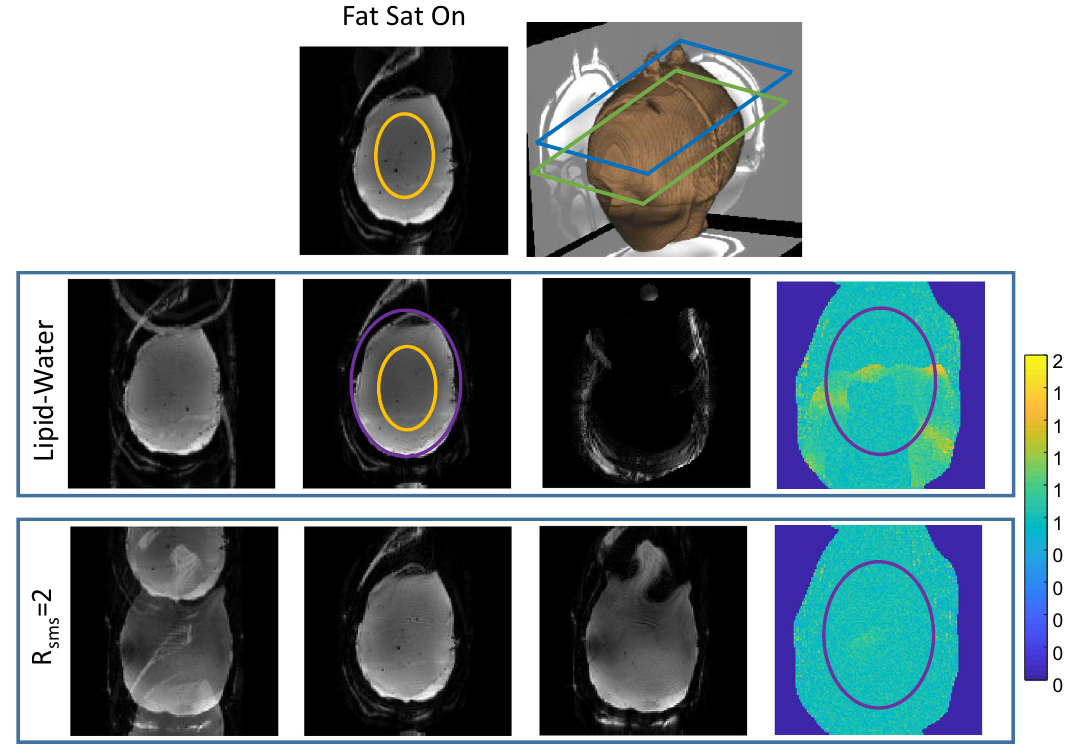
Figure 2. Phantom scanning—comparison of Lipid-Water and SMS reconstruction. Top row—Image acquired with fat suppression and a 3D rendering showing the phantom shape, the main slice location (green frame) and a second slice (blue frame). Second row—Images acquired without fat suppression. From left to right—image with standard reconstruction (with overlapping lipid signal), reconstruction of separated water and lipid images, and a g-factor map for the water image. The lipid image is placed at the correct location (without a shift) by the reconstruction algorithm. Bottom row—Images acquired with R sms = 2. From left to right—image with standard reconstruction (with overlapping slices), reconstructed two slices images and g-factor map for the first slice. The ROIs shown in the orange overlay were used to estimate the SNR, while the purple ROI shows the “brain” region in the images. The g-factor color-map range is Figure S1 in the Supporting Information shows an analysis of the added relative signal of the lipid artifact versus the flip angle of the Fat Suppression pulse, as well as energy fraction the Fat Suppression pulse contributes. Flip angles in the range of 40–180° for the fat suppression pulse were examined in conjunction with an R sms = 2, 90° flip angle excitation pulse (as a representing example). A lipid signal close to zero was measured at a fat sup- pression flip angle of 125°, compared to a default flip angle of 110° used in this sequence, which contributes ~ 66% of the total energy of the product GRE-EPI. The strategy of reducing the flip angle of the fat suppression can be used to reduce global SAR 37 . For example, a choice of 80° will introduce only ~ 7% lipid artifact. This same flip angle (80° for the fat suppression pulse) was also mentioned as the fat suppression flip angle chosen in Ref. 43 . Note, that the lipid artifact intensity can vary depending on additional factors—such as B 0 distribution, specific sensitivity maps, TE and TR parameters—introducing negligible artifacts in some cases and strong in others.